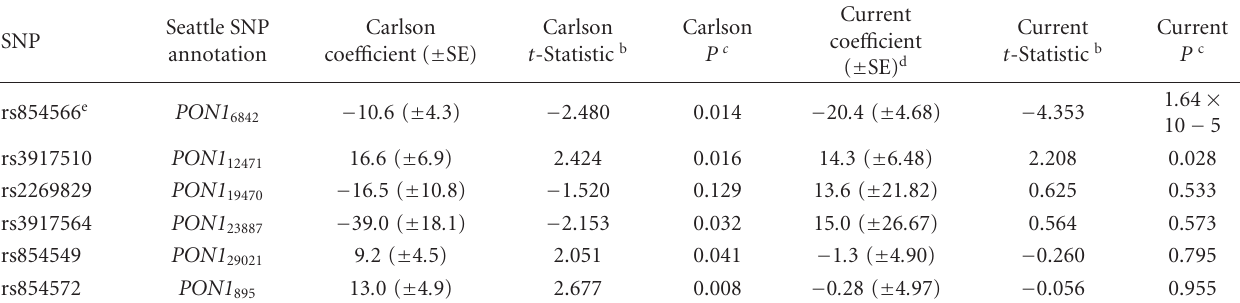
Table 5: Comparison of SNPs found significant in prior Carlson et al. a study with current, non-overlapping sample.